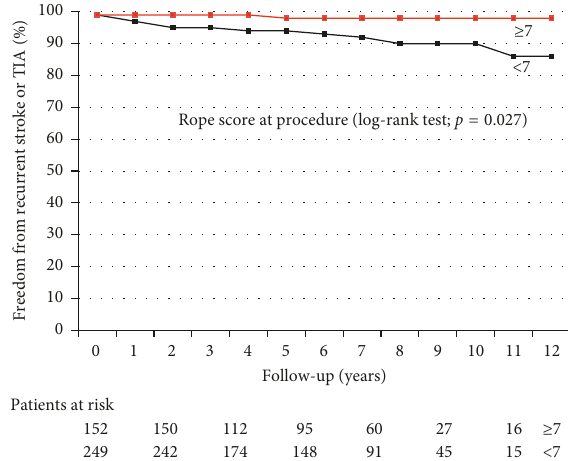
Figure 3: Kaplan–Meier plot showing freedom from recurrent stroke and/or TIA over a 10-year time frame in patients aged ≥ 55 years versus < 55 years at the time of the procedure. p � 0 . 011 by log-rank test.